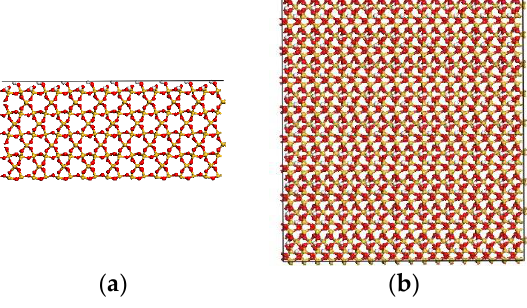
Figure 3. ( a ) Side view of S (100) surface; and ( b ) top view of S (100) surface.